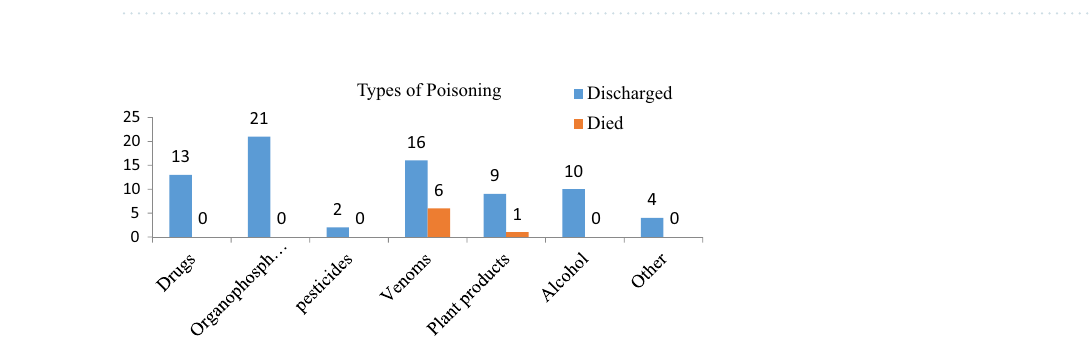
Table 1. Sociodemographic characteristics of children with poisoning who were presented to the University of Gondar comprehensive specialized hospital from October 1, 2014 to October 1, 2020, North Gondar, Ethiopia.